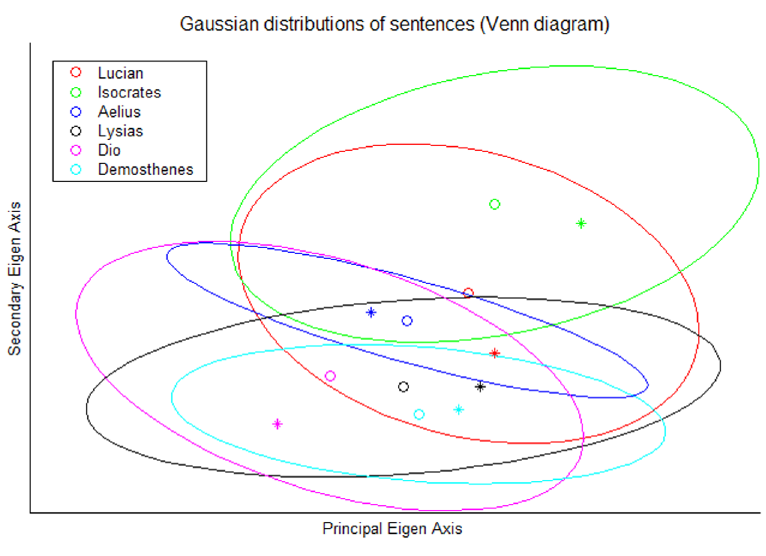
Fig 11. Visualization of the point set of Fig.9 as Gaussian distributions. The distribution of the sentences of each author is depicted as an ellipse. The center of each distribution is marked by a circle, and the median is marked by an asterisk. The second viewpoint from which to consider the orators is in groups—the classical Attic and the Imperial orators. It is interesting to note that Demosthenes and Isocrates do not coincide, but Lysias is the connecting ellipse between the two. This showcases that, albeit classical Attic orators, they have distinct writing styles. They are, however, undeniably Attic, and the affinities with Lysias, the quintessential Atticisist, prove that they share common traditional elements. Close examination of the Imperial orators proves that they also have distinct similar elements. All three ellipses coincide considerably, which would mean that the revived Atticism opted for standardized schemas for self-validation. In the future, isolating certain constructions and determining whether they are particular to Atticism in general, classical, or Imperial Atticism will further this